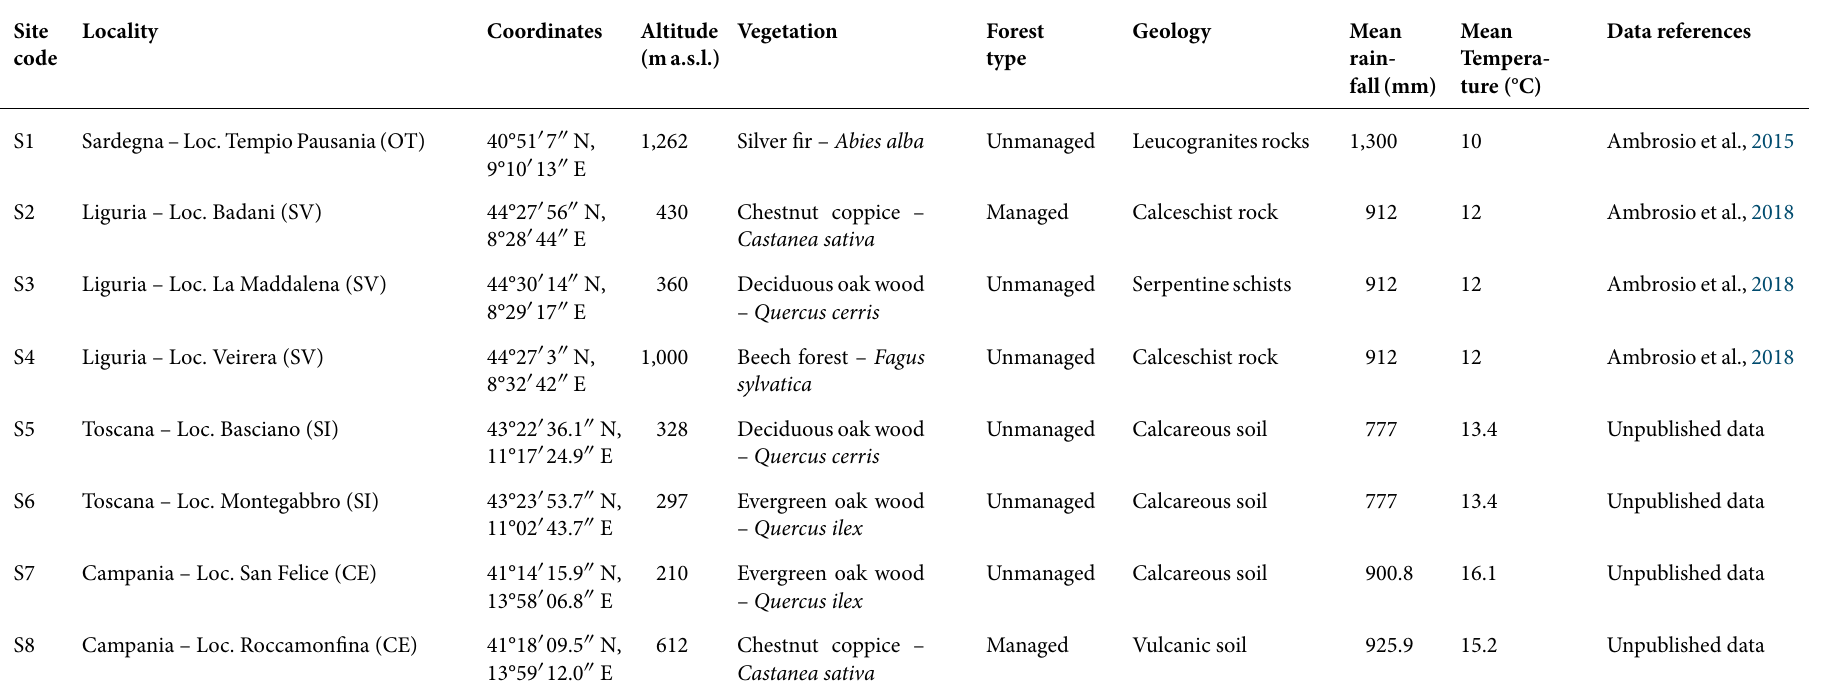
Table 1 Characteristics of study